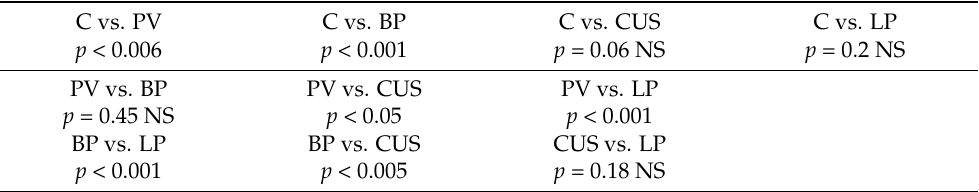
Table 2. Expression of STAT4 in study groups. C—control group; BP—pemphigoid; PV—pemphigus vulgaris; LP—lichen planus; CUS—chronic ulcerative stomatitis.